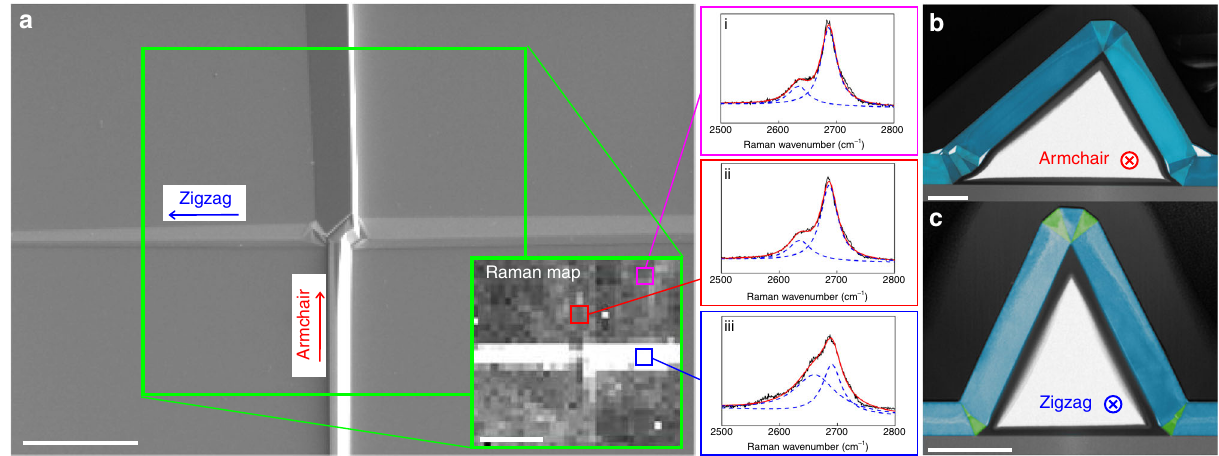
Fig. 5 Twin boundaries creating unusual Raman-active stacking in graphite. a SEM image of two orthogonal kink bands intersecting in the crystal. Inset maps the Raman intensity ratio of the 2630 cm − 1 and 2690 cm − 1 peaks in the 2D peak. The ratio is drastically modi fi ed locally to the zz kink band (white contrast in inset). Scale bars 10 μ m. Individual Raman 2D spectra are shown for ( i ) pristine graphite, ( ii ) the ac twin and ( iii ) the zz twin boundaries. b Large fi eld of view bright fi eld STEM image of the ac kink band. In this striation the basal stacking in each crystalline region is equivalent (Bernal stacked). False colour is used to highlight areas of lattice separated by a twin boundary. This ac kink band shows some delamination yet gives the same 2D Raman signal as pristine graphite. Scale bar 250 nm. c Large fi eld of view bright fi eld STEM image of the zz kink band. Regions of Bernal stacking are false coloured blue while small areas of crystal that do not exhibit Bernal stacking and are instead highly faulted or AA ’ stacked are false coloured green. These areas are thought to contribute to the modi fi cation of the Raman 2D signal. Scale bar 250